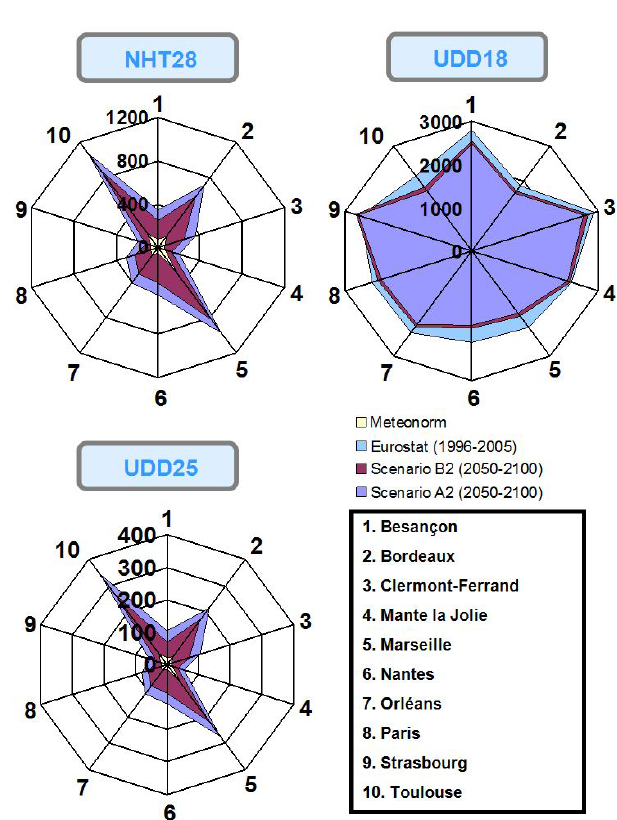
Fig. 7. NHT28, UDD18 and UDD25 mean values for 10 French cities for the scenarios A2 and